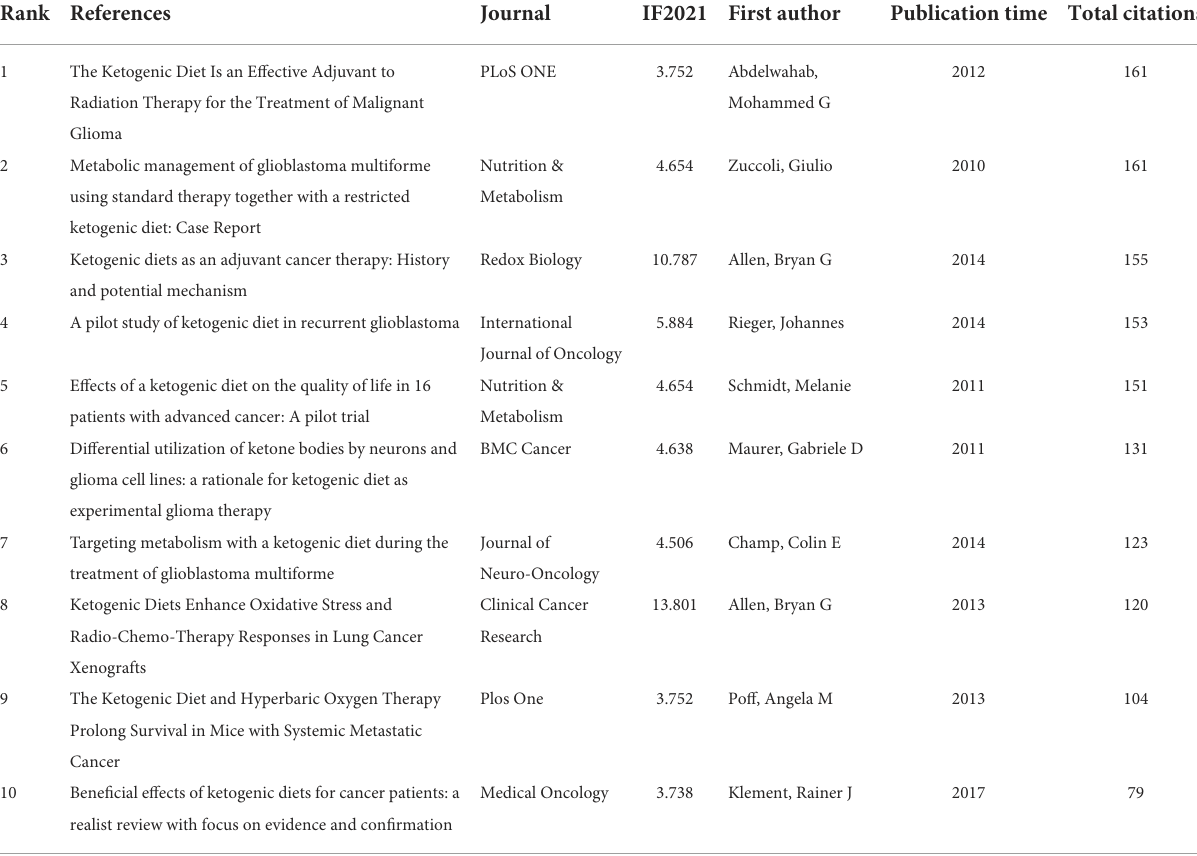
TABLE 6 The top 10 high-cited references in the field of the ketogenic diet on cancer